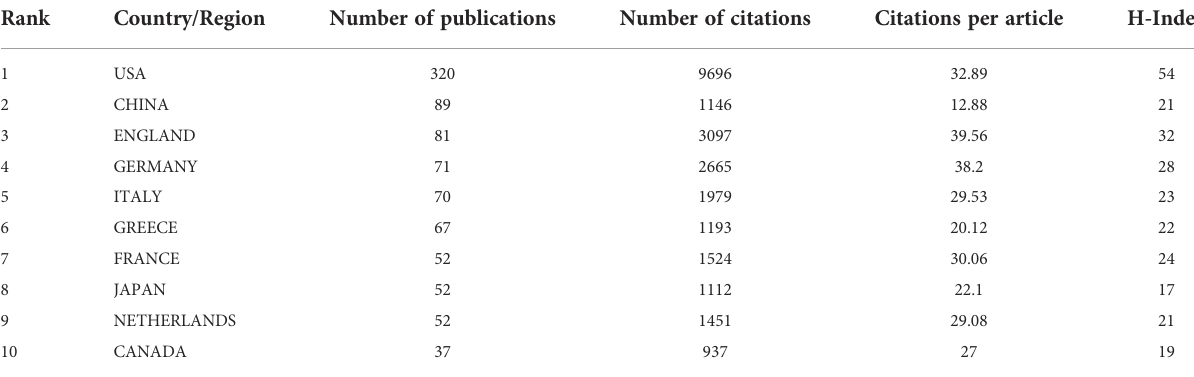
TABLE 1 The top 10 countries/regions contributing to targeted immunotherapy for